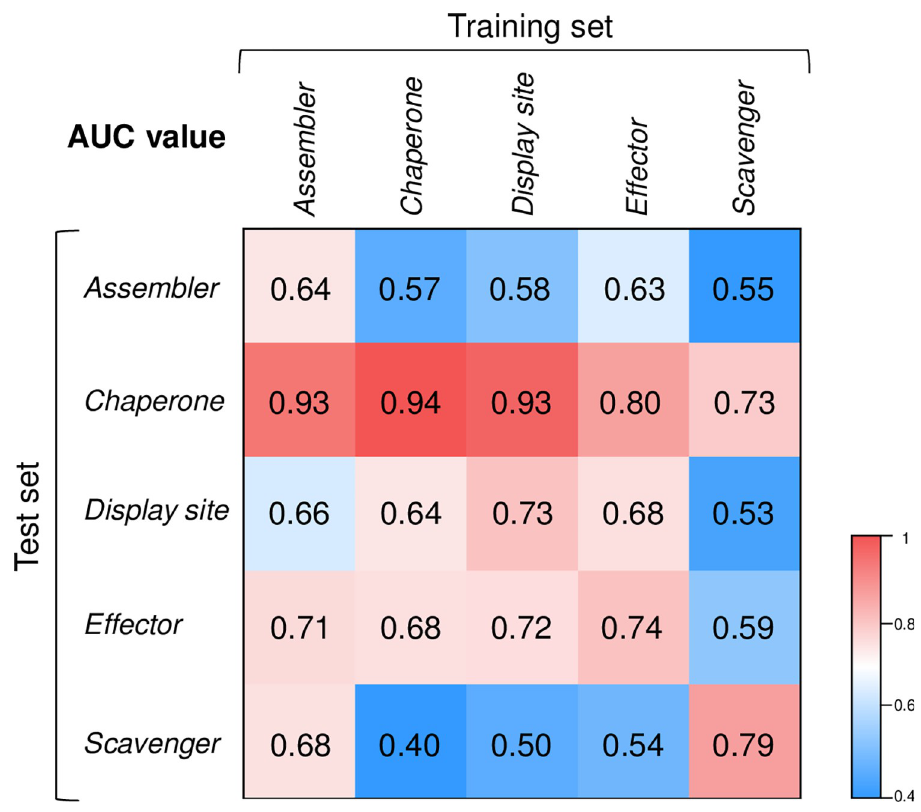
Fig 3. Cross-functional validation results. Functions on the x-axis were used to fine-tune PCLM model, and functions on the y-axis were used for model